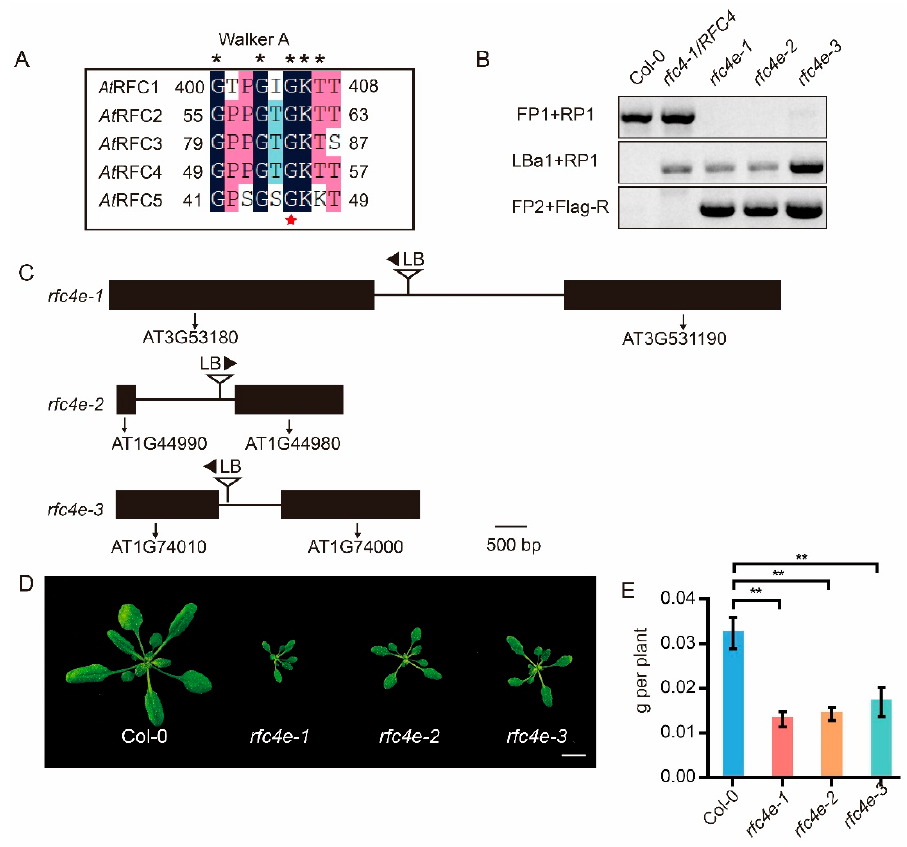
Figure 1. rfc4e mutants were generated by site-directed mutagenesis. ( A ) Sequence similarities in the Walker A domain among At RFC1/2/3/4/5 subunits. Conserved amino acids in the Walker A domain are indicated with asterisks, and the mutated Gly is indicated with a red star. ( B ) Genotypic analysis of the wild type (Col − 0), rfc4 − 1 / RFC4 , rfc4e − 1, rfc4e − 2, rfc4e − 3 . ( C ) Schematic diagrams of T − DNA insertion position of rfc4e − 1, rfc4e − 2 and rfc4e − 3 , respectively. Black boxes and lines indicate genes and untranslated regions flanked the insertion sites. ( D , E ) Phenotype and fresh weight of Col − 0, rfc4e − 1, rfc4e − 2 and rfc4e − 3 seedlings at 18 days after germination. Bar = 1 cm. Error bars indicate ± SD (* p < 0.05, ** p < 0.01).